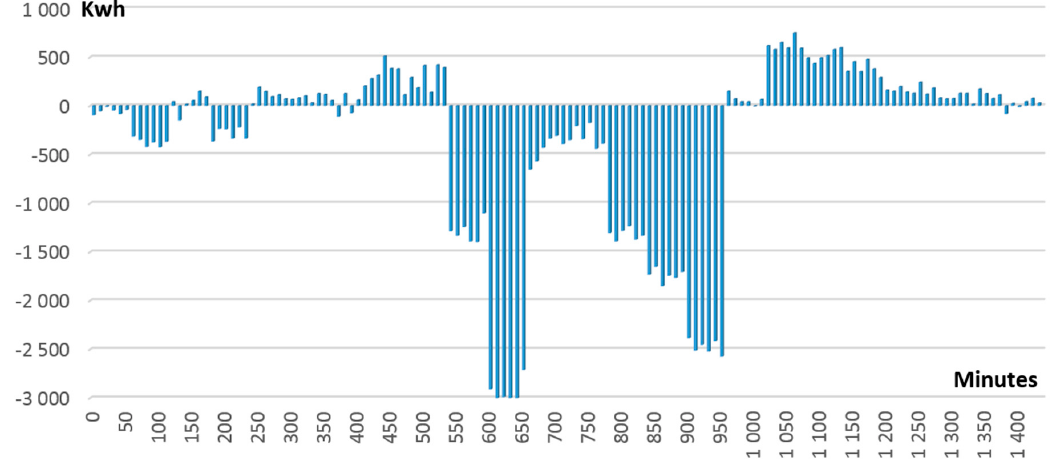
Figure 10. ∆ ± differences reported by smart contracts managing DEPs energy profiles.